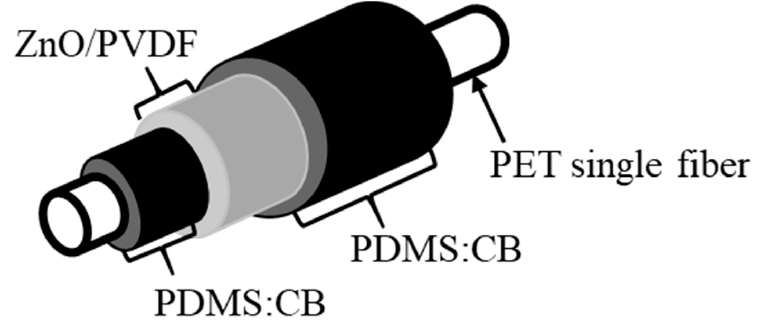
Figure 1. The labeled schematic of the fiber nanogenerator.